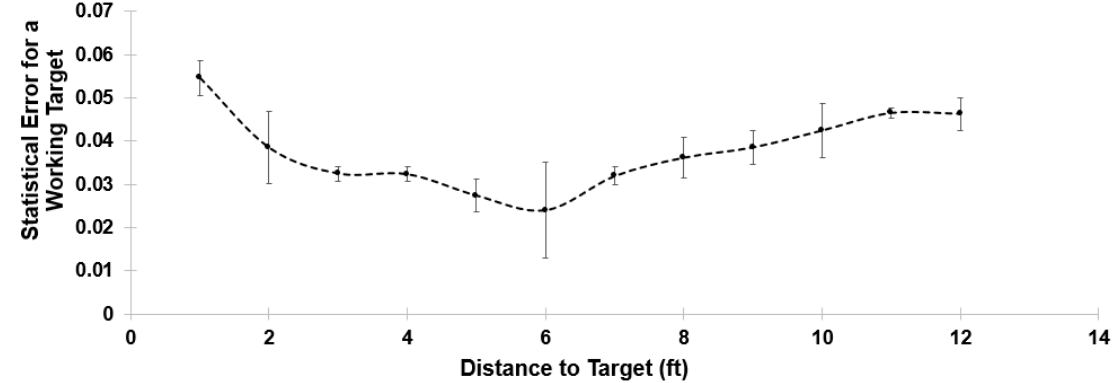
Figure 9. Statistical error at varying distances for a working